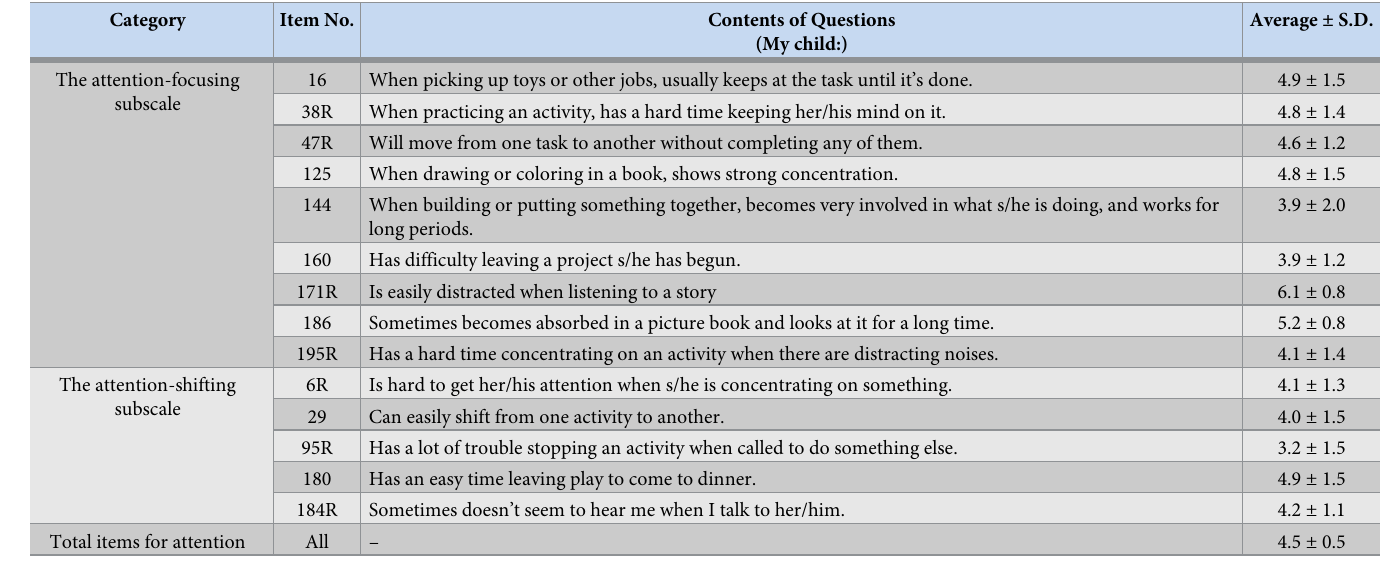
Table 1. The CBQ rating items and scores. Seven scales (S1 Fig). Category Item No. Contents of Questions